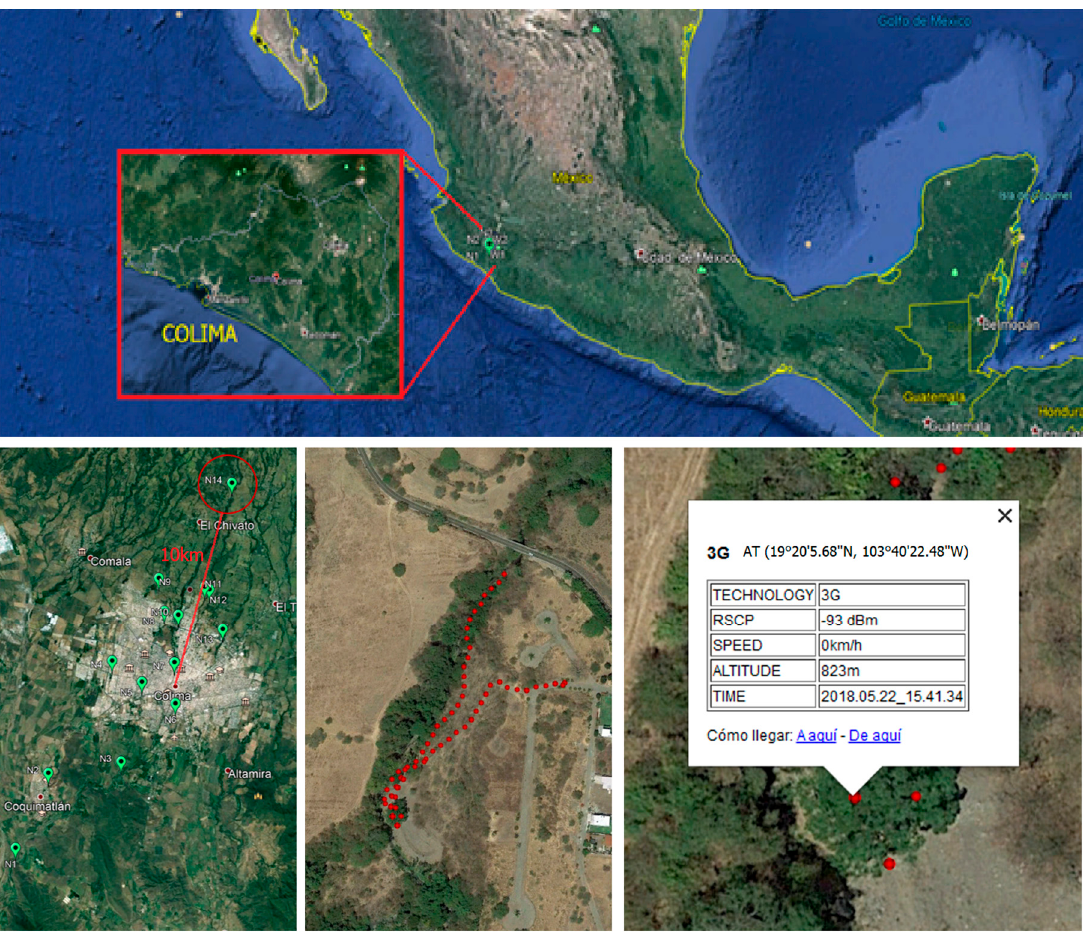
Figure 16. Field work: 3G signal measurements for deployment.